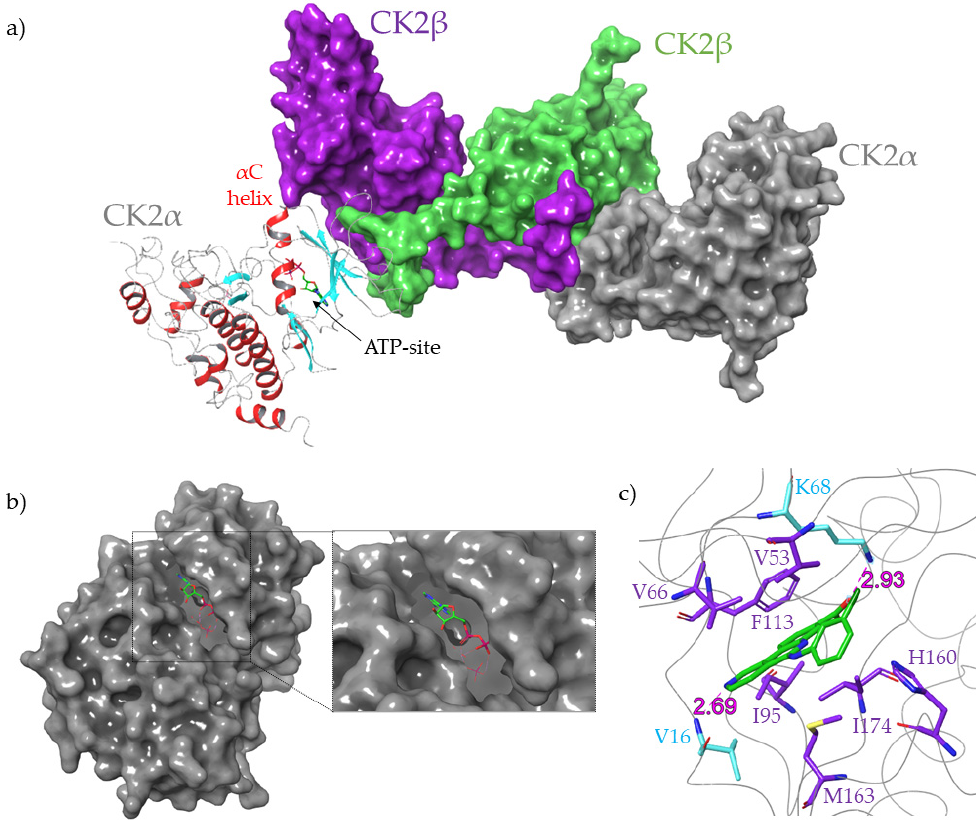
Figure 2. Overview of the structure of the CK2 holoenzyme, the catalytic subunit CK2 α with ADP bound in the ATP-site and the key interactions between residues in the ATP-site of CK2 α and the ATP-competitive inhibitor CX-4945. ( a ) Heterotetrameric quaternary structure of CK2 with AMPPNP bound in the ATP-site of CK2 α (PDB: 1JWH). The catalytic α subunits are shown in grey and in ribbon form; α -helices are shown in red and β -strands are shown in cyan in the ribbon form; the regulatory β subunits are shown in purple and green. ( b ) Structure of CK2 α with ADP bound in the ATP-site (PDB: 6YPN). ( c ) Structure of ATP-competitive inhibitor CX-4945 bound in the ATP-site of CK2 α (PDB: 3NGA). CX-4945 is shown in green. Residues which form hydrogen bonds with the inhibitor are shown in cyan with the distances between the residues and the inhibitor shown in Å; residues which form van der Waals interactions with the inhibitor are shown in purple.